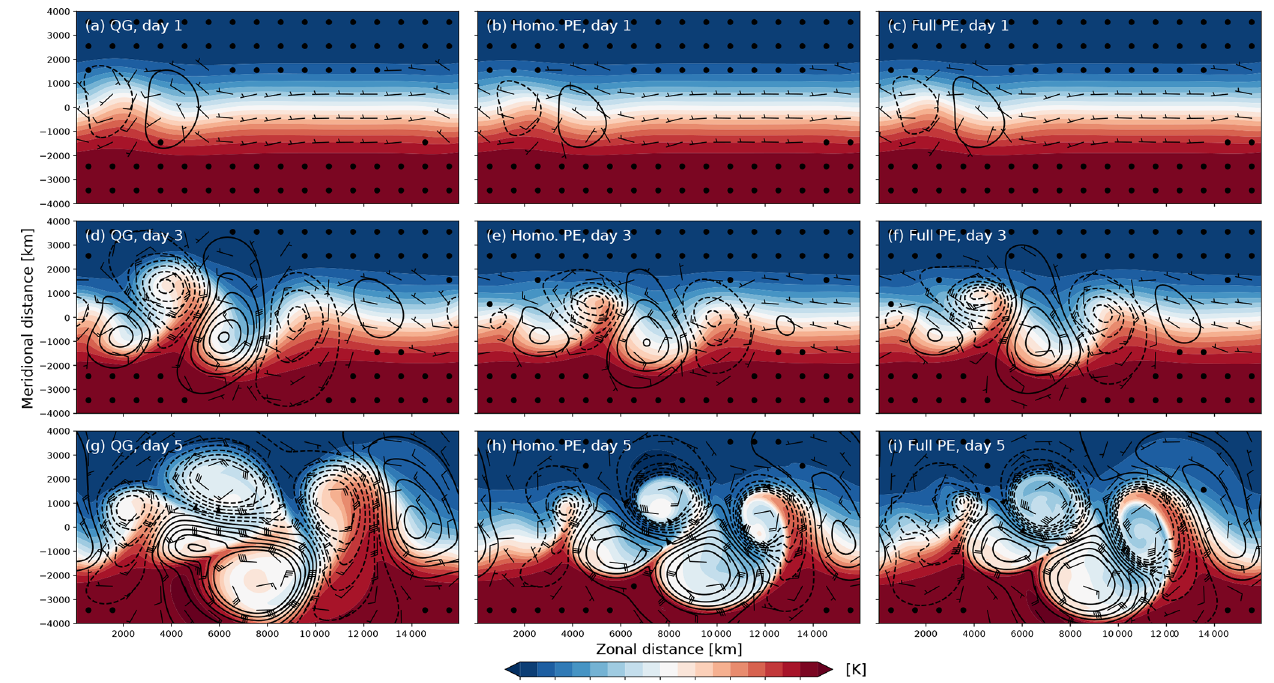
Figure A1. The same as Fig. 2 but for simulations on an f plane instead of a β plane.